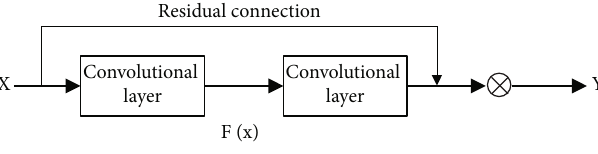
Figure 2: The basic unit of residual